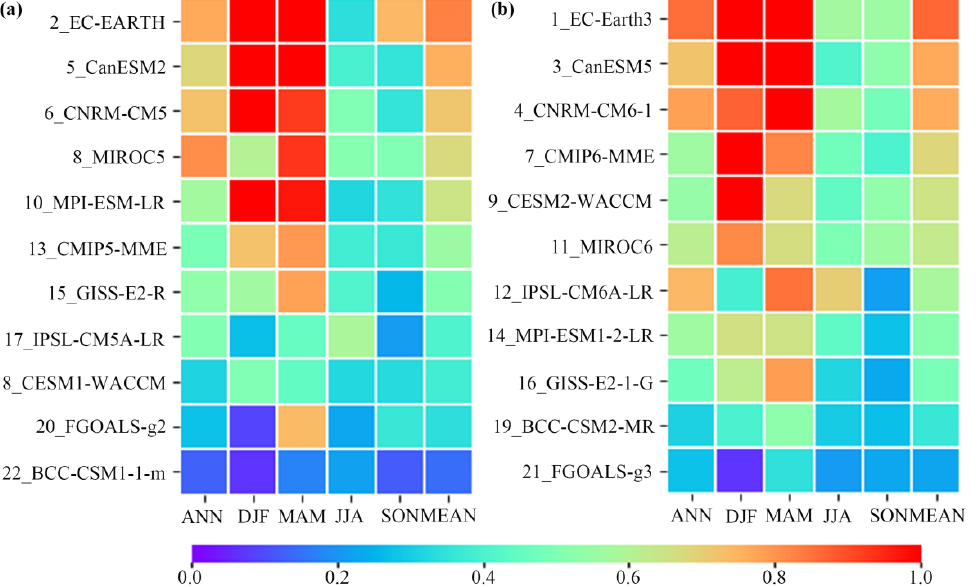
Figure 8. Portrait diagrams for TS score of the (annual, seasonal) mean precipitation in 2015 – 2020 by the CMIP5 ( a ) and CMIP6 ( b ) GCMs. From left to right are ANN, DJF, MAN, JJA, SON, and average means. The GCMs’ names listed on the left follow their ranks; The number before the name is the rank of the model among all GCMs.